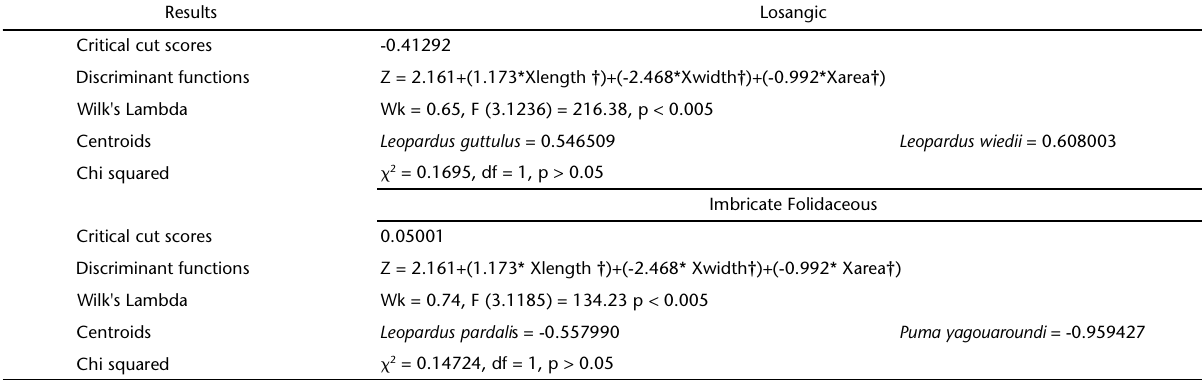
Table II. Summary of the identification process for small Neotropical felids ( Leopardus guttulus , L . wiedii , L . pardalis , and Puma yagouaroundi ) using the linear discriminant analysis (ADL) of metrics of guard hair scales. Results Losangic Critical cut